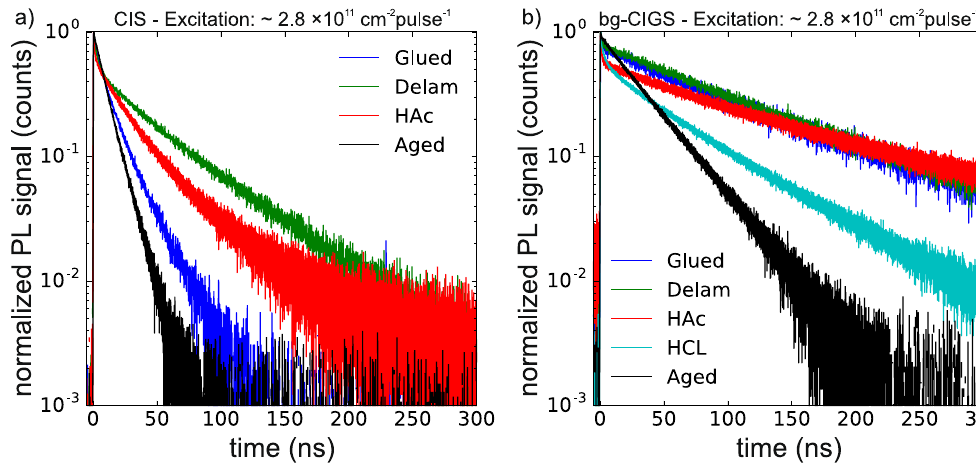
Figure 3. Normalized PL transients of the CIS and the back graded CIGS absorber. Various surface modifications are applied demonstrating the effect of the surface recombination